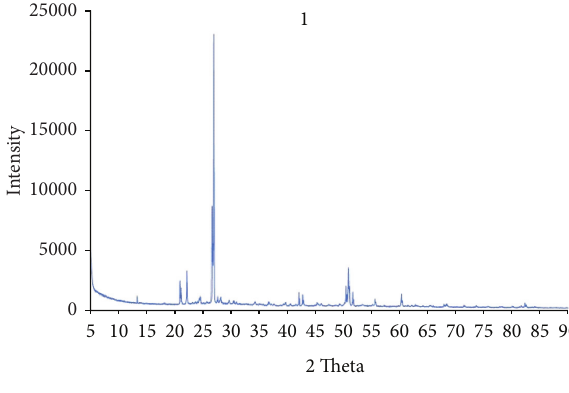
Figure 9: Mix 2 XRD